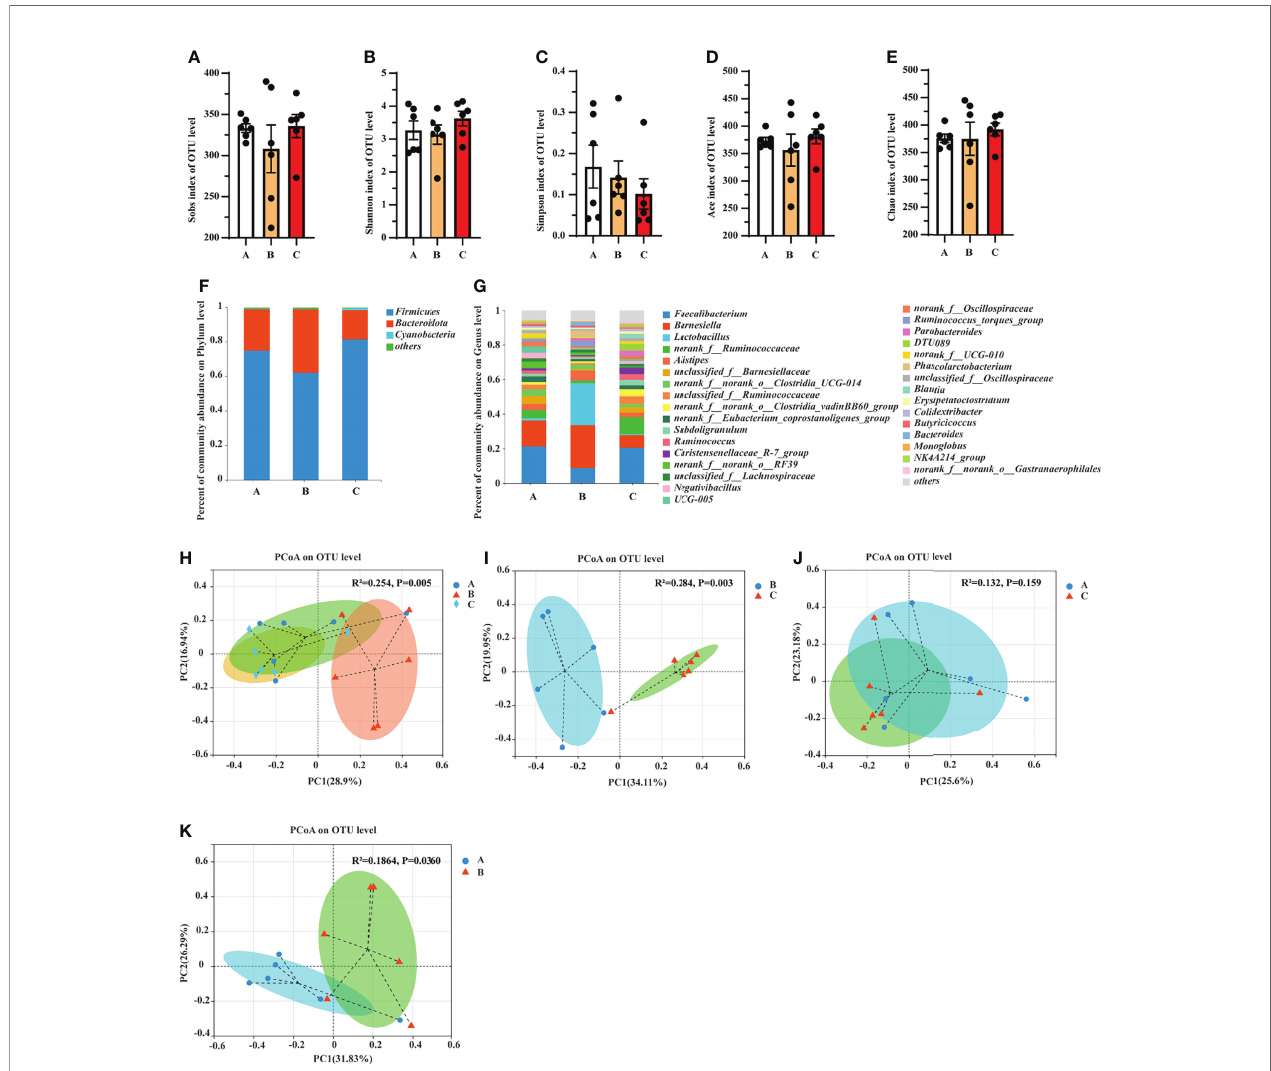
FIGURE 10 | Groups A, B, and C are the control group, the pair-feeding group, and the OTA+AFB1 group, respectively. (A – E) The effects of OTA and AFB1 on the alpha diversity of the gut microbiota in pullets after 42-day trial (n = 6, mean ± SEM). (A) Sobs index of the community diversity. (B) Shannon index of the community richness. (C) Simpson index of the community diversity. (D) ACE index of the community diversity. (E) Chao index of the community diversity. Data were analyzed with ANOVA and Tukey ’ s HSD. (F, G) The effects of OTA and AFB1 on the relative abundance of the gut microbial community structure in pullets after 42-day trial (n = 6). (F) Relative abundance of gut microbiota at the phylum level. (G) Relative abundance of gut microbiota at the genus level. (H – K) The effects of OTA and AFB1 on the PCoA (Bray – Curtis distance) plot of the gut microbiota in pullets after 42-day trial (n = 6). (H) The PCoA in the three treatments. (I) The PCoA in Group B and Group C (J) The PCoA in Group A and Group C (K) The PCoA in Group A and Group (B) OTA, ochratoxin A; AFB1, a fl atoxin B1; HSD, honestly signi fi cant difference; PCoA, principal coordinate